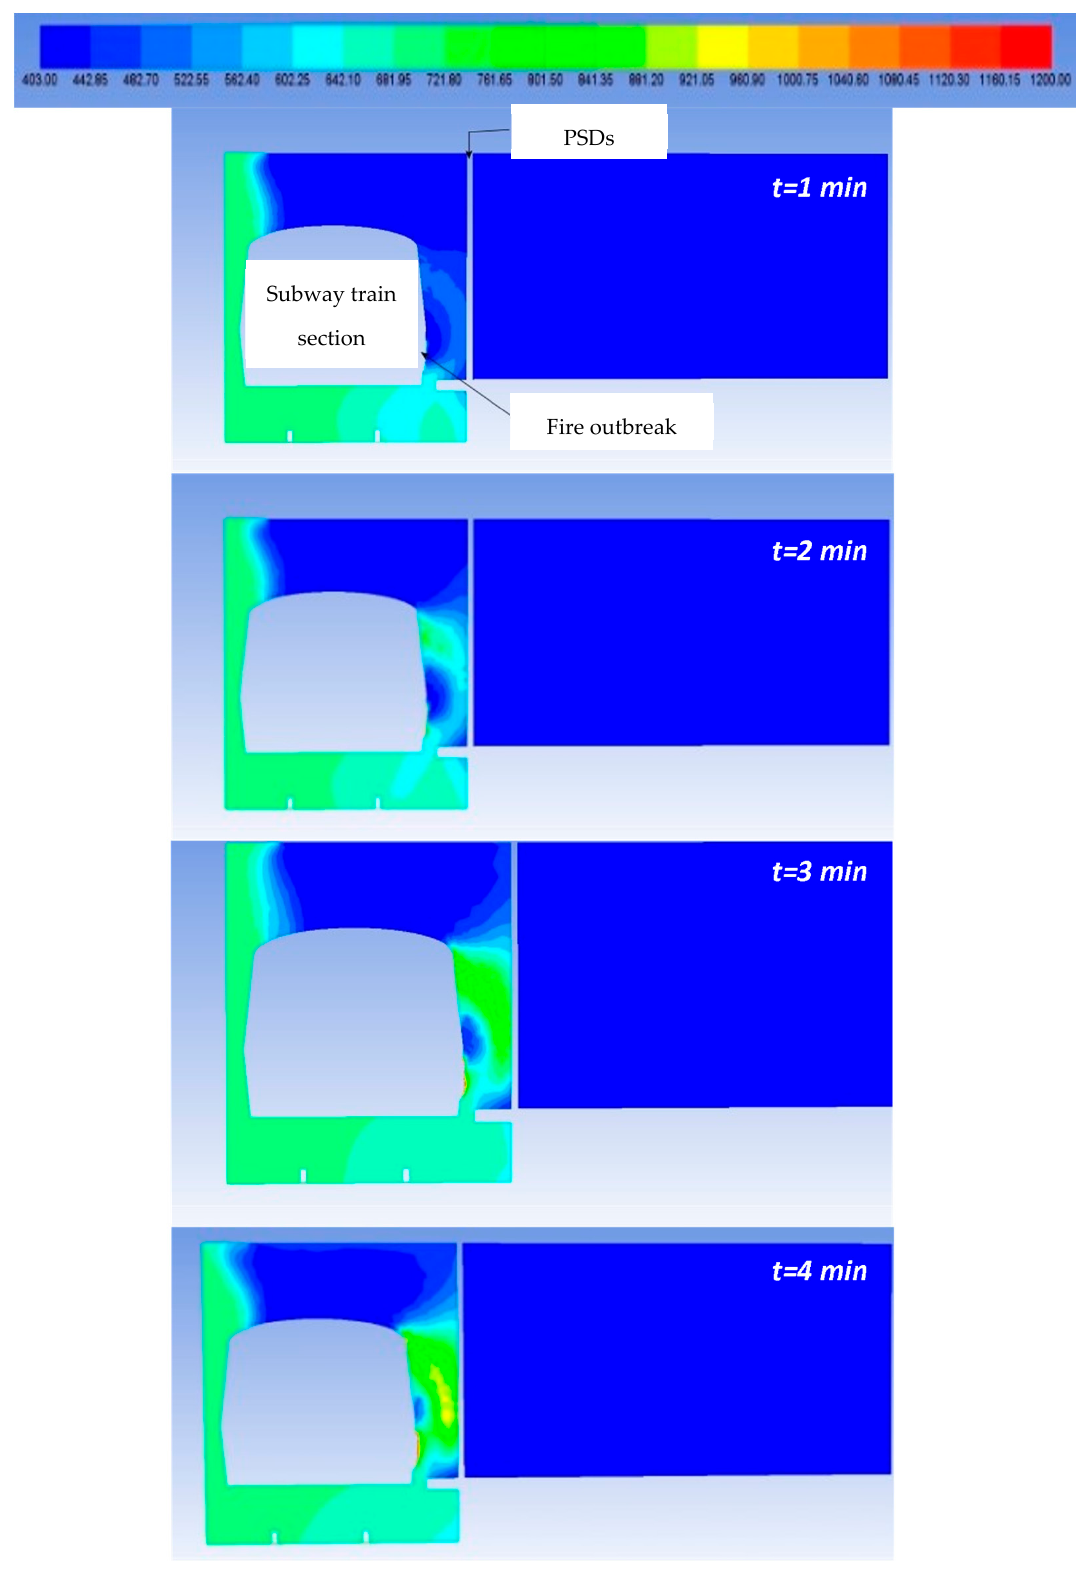
Figure 16. CO 2 contours (ppm)—cross section through the fire outbreak (minutes 1–4).